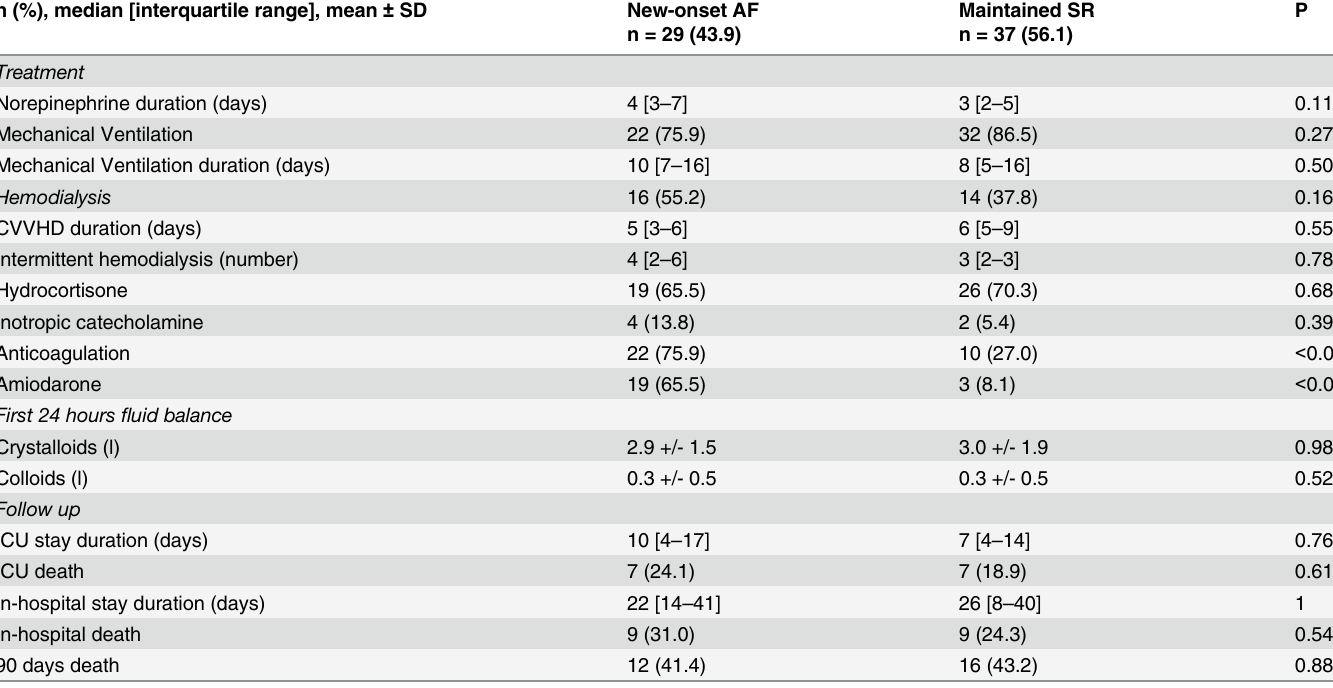
Table 5. In-ICU Management According To The Onset Of Atrial Fibrillation. n (%), median [interquartile range], mean ±